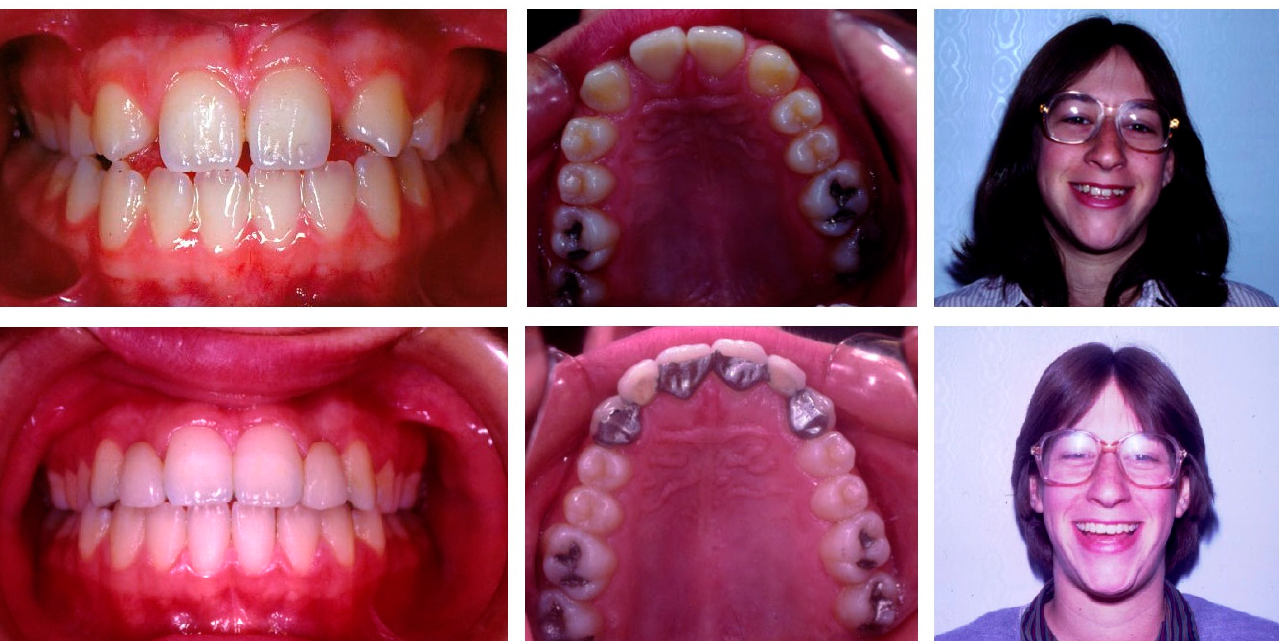
Figure 3. Pre- and post-treatment photographs of a 16-year-old female with missing maxillary lateral incisors treated with spaces opening for Maryland bridge.